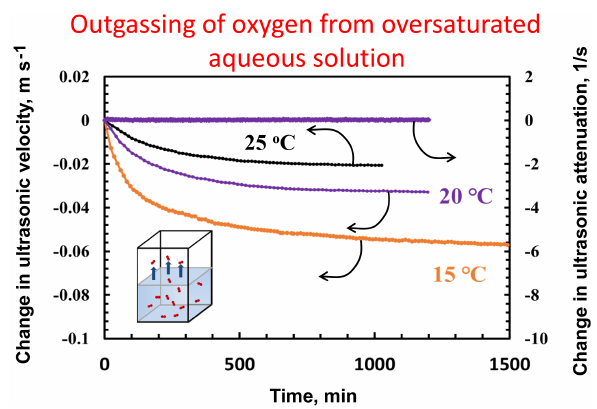
Figure 8. Ultrasonic monitoring of outgassing of oxygen from oversaturated aqueous solution. Evolution of ultrasonic velocity and attenuation (15.1MHz, 15, 20, 25 ◦ C) of dissolved oxygen during the outgassing process from 1.1mL of oxygen supersaturated so- lution in ultrasonic cell of a HR-US 102 ultrasonic spectrometer (Sonas Technologies Ltd. Dublin). The solutions were prepared by fast catalytic decomposition of 20mM of hydrogen peroxide (Yue- long,